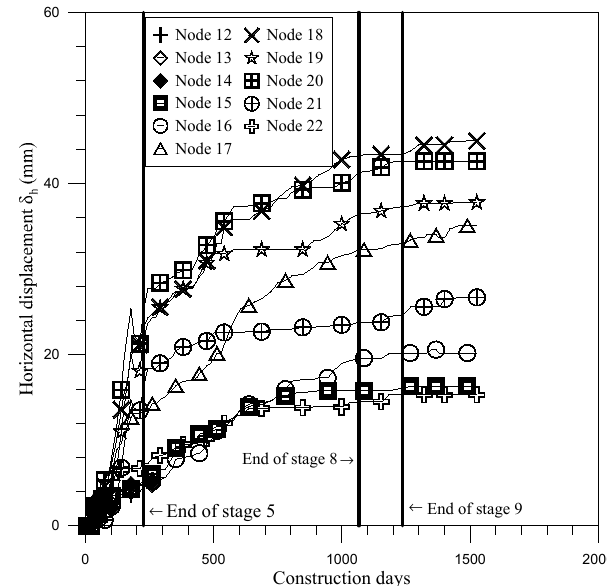
Figure 14. Deflection of points 12–22.